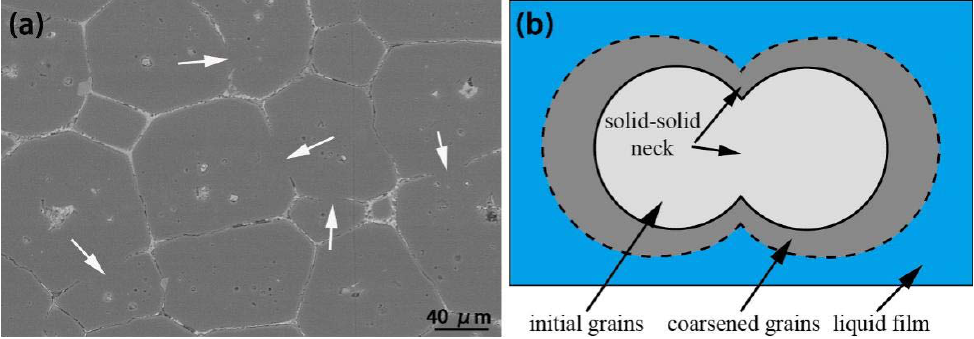
Figure 13. SEM image of the sample soaked at 610 °C for 10 min ( a ) and schematic illustration ( b ) of the coarsening of the solid–solid neck during the SSIT.